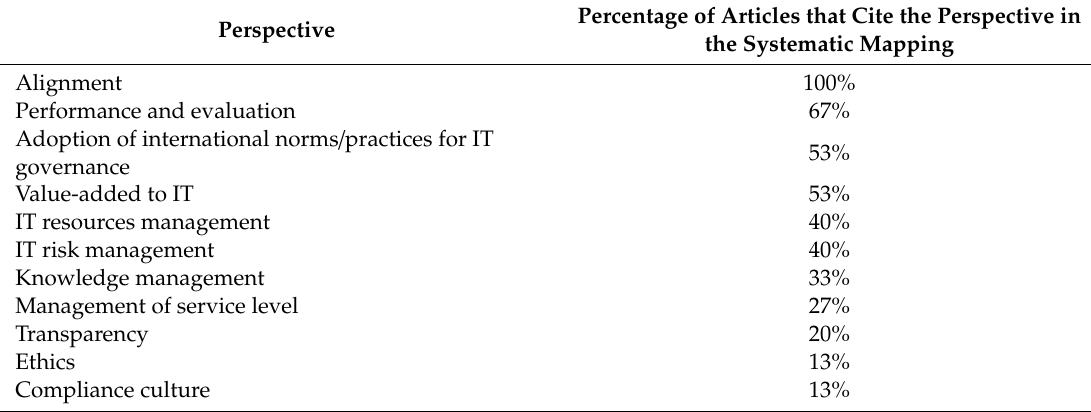
Table 1. Level of importance that articles from the systematic mapping attribute to each perspective. Percentage of Articles that Cite the Perspective Perspective